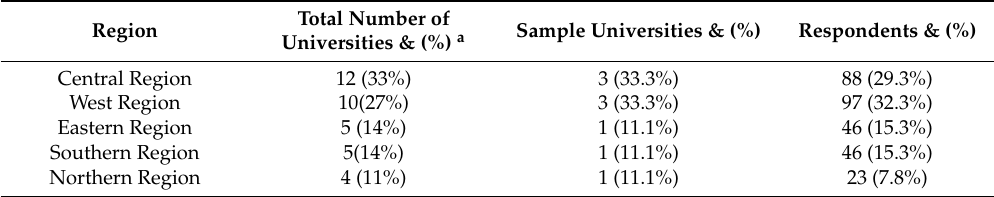
Table 1. Distribution of